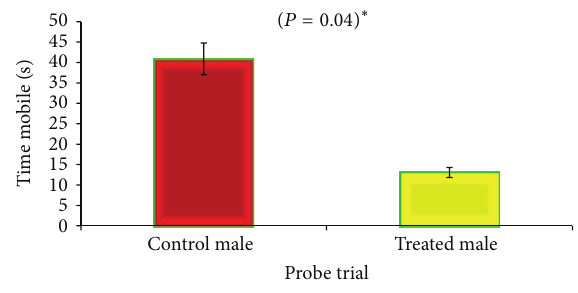
Figure 6: Comparison of time mobile between GABA B antagonist and saline treated male albino mouse during probe trial of Morris Water Maze test. 𝑃 value indicates the result of 2-sample 𝑡 -test.